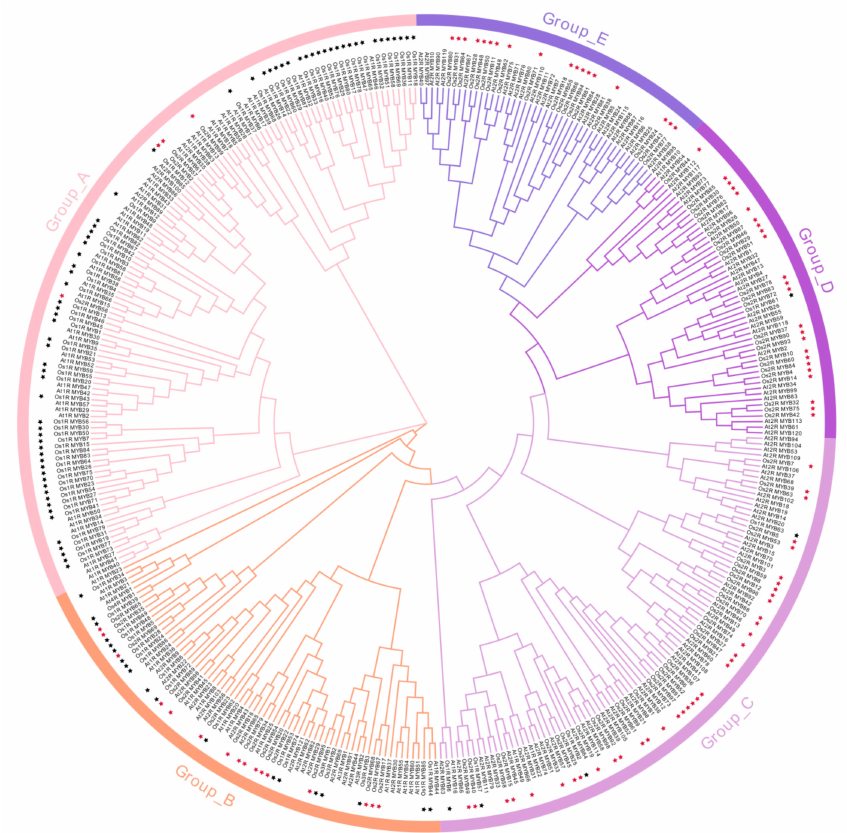
Figure 2. Phylogenetic relationship of Oryza sativa L. and Arabidopsis MYB proteins. The phylogenetic tree of MYB proteins was constructed by the neighbor-joining method of Mega-X with a bootstrap value set to 1000. It was classified into five groups (Group_A/B/C/D/E) according to the sequence characteristic of proteins. The asterisk indicates a protein origin from rice, and the crimson asterisk represents R2R3_MYB